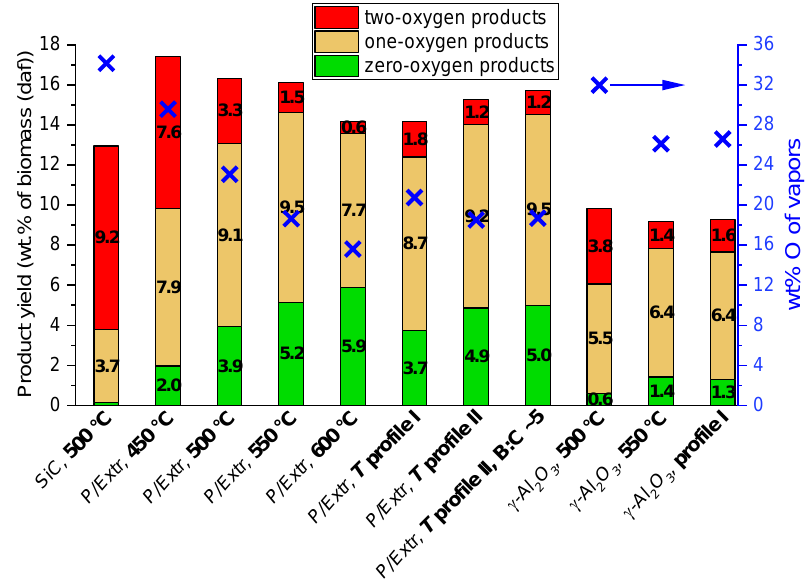
Figure 11. Product yield of vapor compounds grouped as containing zero oxygen atoms, one oxygen atom, or two oxygen atoms. The cumulative yields at B:C ~4, unless indicated otherwise (B:C ~5 for one test), are shown. P/Extr refers to P/HZSM-5/γ-Al 2 O 3 . Table 3. Properties of the accumulated non-condensed vapors at the indicated B:C ratios that are important for fuel applications. In addition, the atomic CO/CO 2 ratio in the gas is shown.